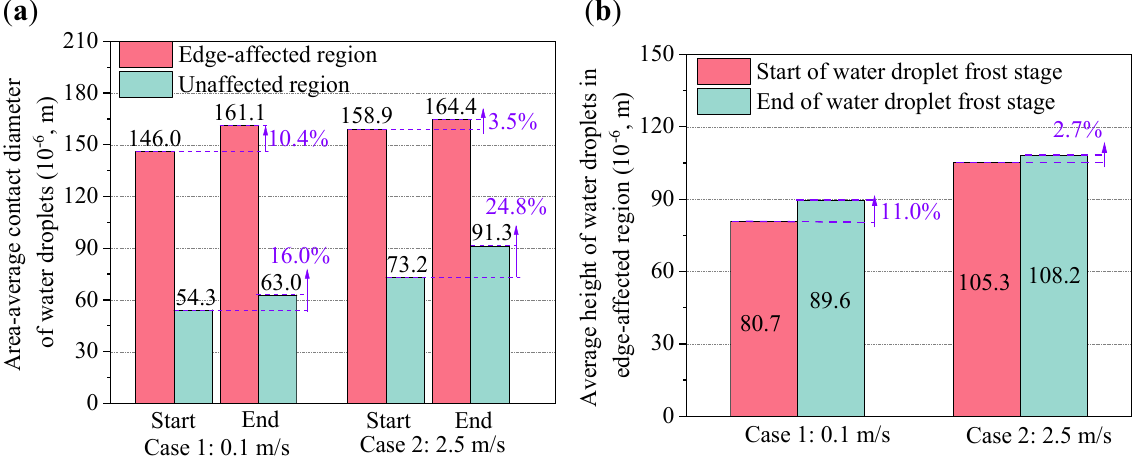
Figure 10. Water droplet size characteristics: ( a ) area-average contact diameter, and ( b ) average height of water droplets. Figure 9. ( a ) Duration of water droplet frozen stage, and ( b ) average freezing wave velocity.